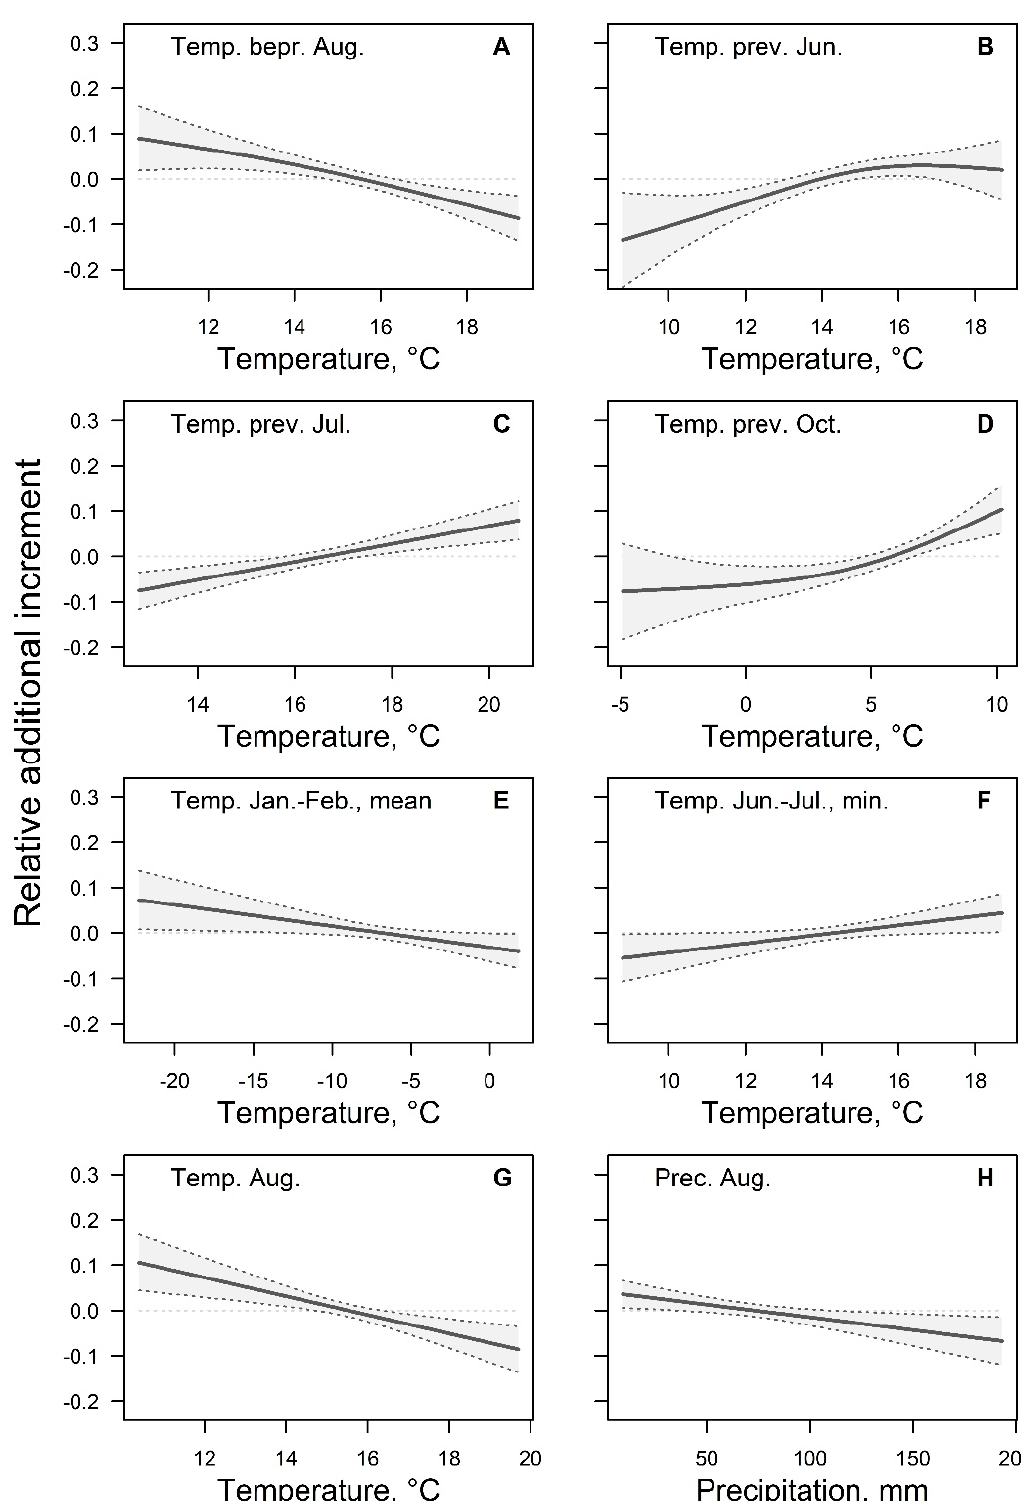
Figure 5. The estimated effects of meteorological variables ( A – H ) on the relative additional height increment of Scots pine (as represented by the residual chronologies) of conventionally managed stands across the north-eastern Baltic Sea region in Finland, Estonia, and Latvia. The dotted lines/shaded regions show 95% confidence intervals of the responses. Panels are ordered chronologically. bepr.—year before previous, prev.—previous year.